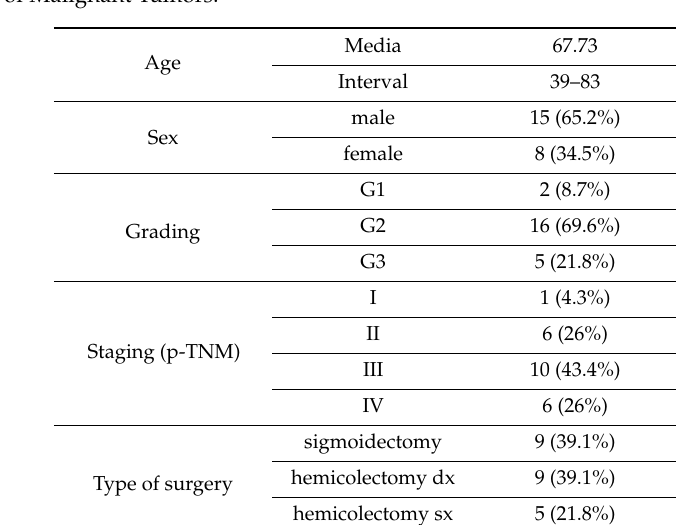
Table 1. Clinical and pathological characteristics of the 23 patients enrolled in the study. TNM: Classification of Malignant